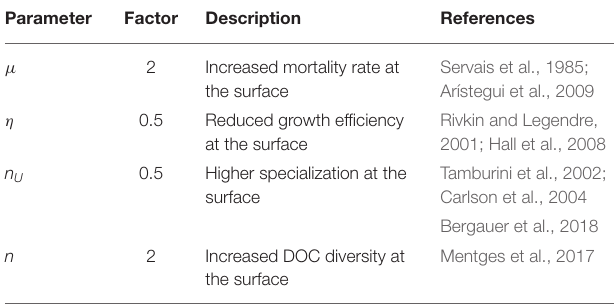
TABLE 2 | Depth-dependent